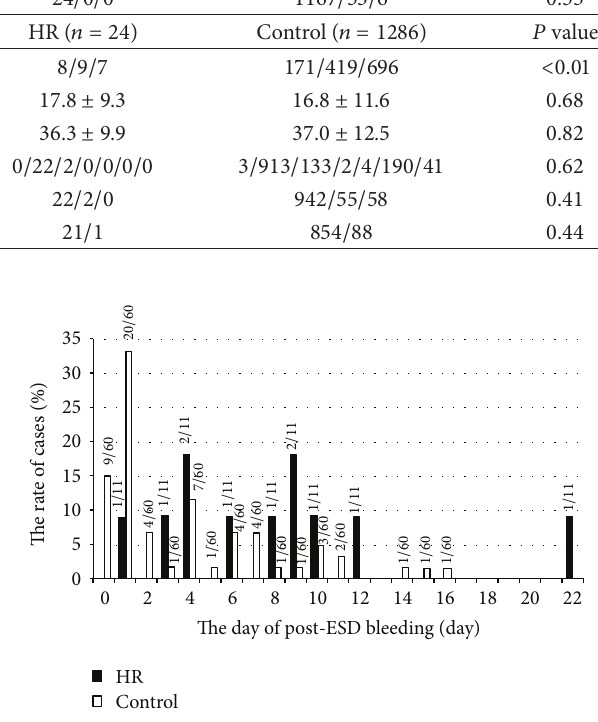
Figure 2: Comparison of the onset of delayed bleeding after ESD between the HR group and the control group. The days of delayed bleeding occurred after ESD in HR group (black bar) and control group (white bar) were shown in the